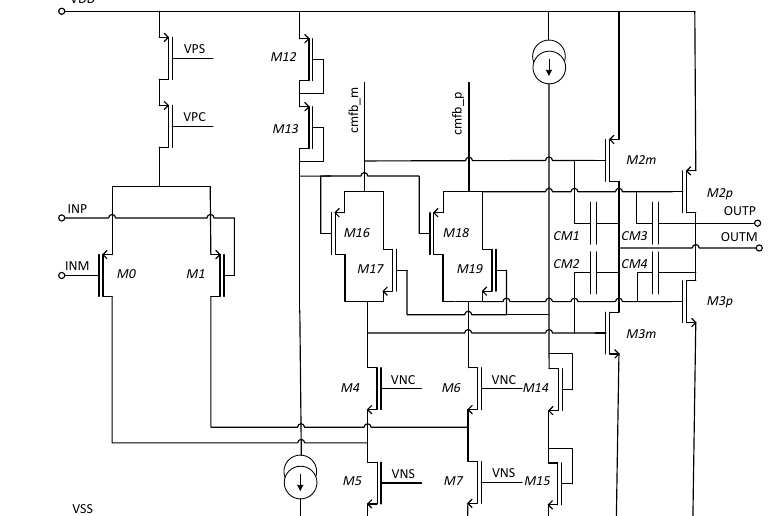
Figure 3. Architecture of the fully differential class AB OTA.